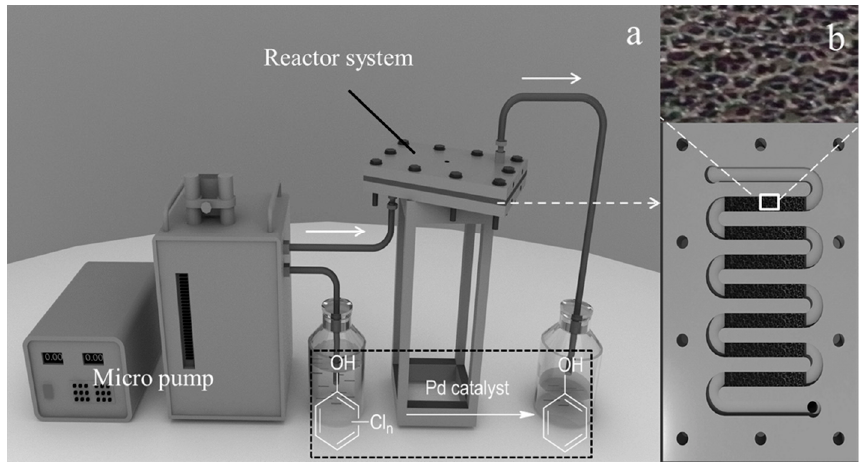
Figure 8. Sketched configuration of the continuous flow Pd/CNT-Ni foam micro reactor system ( a ) and the reaction chamber embedded with a Pd/CNT-Ni foam micro reactor ( b ).